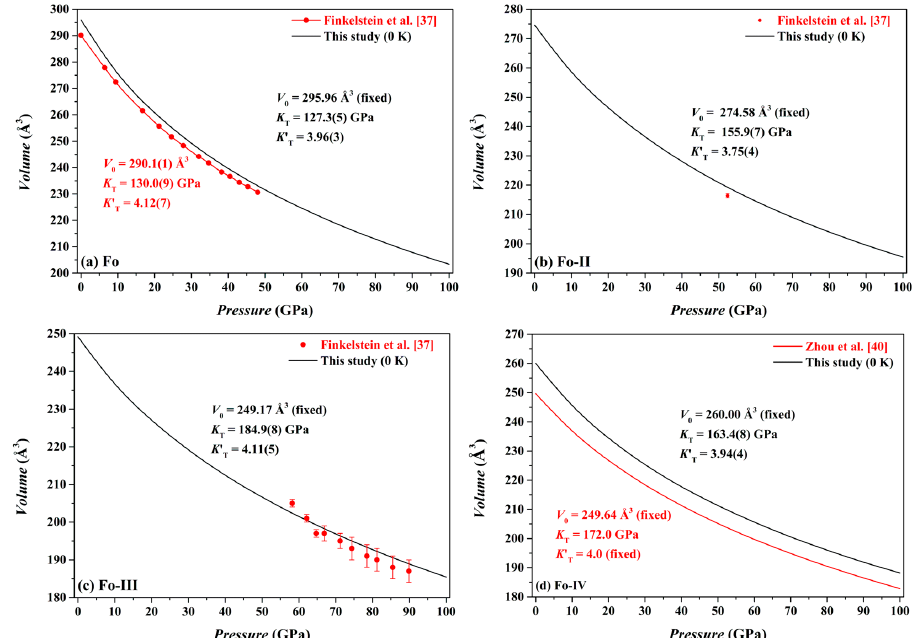
Figure 6. V - P correlation of ( a ) Fo; ( b ) Fo-II; ( c ) Fo-III; and ( d ) Fo-IV. The black curve is drawn through our calculated result (0 K and GGA; Table 4) whereas the red curve is drawn through the experimental data points from Finkelstein et al. (ref. [37]; 300 K) or stands for the calculated result from Zhou et al. (ref. [40]; 0 K and LDA). The symbols in ( a – c ) represent the experimental data from Finkelstein et al. (ref. [37]; 300 K). Table 4. Parameters of 3rd BM-EoS for Fo, Fo-II, Fo-III and Fo-IV at 0 K.